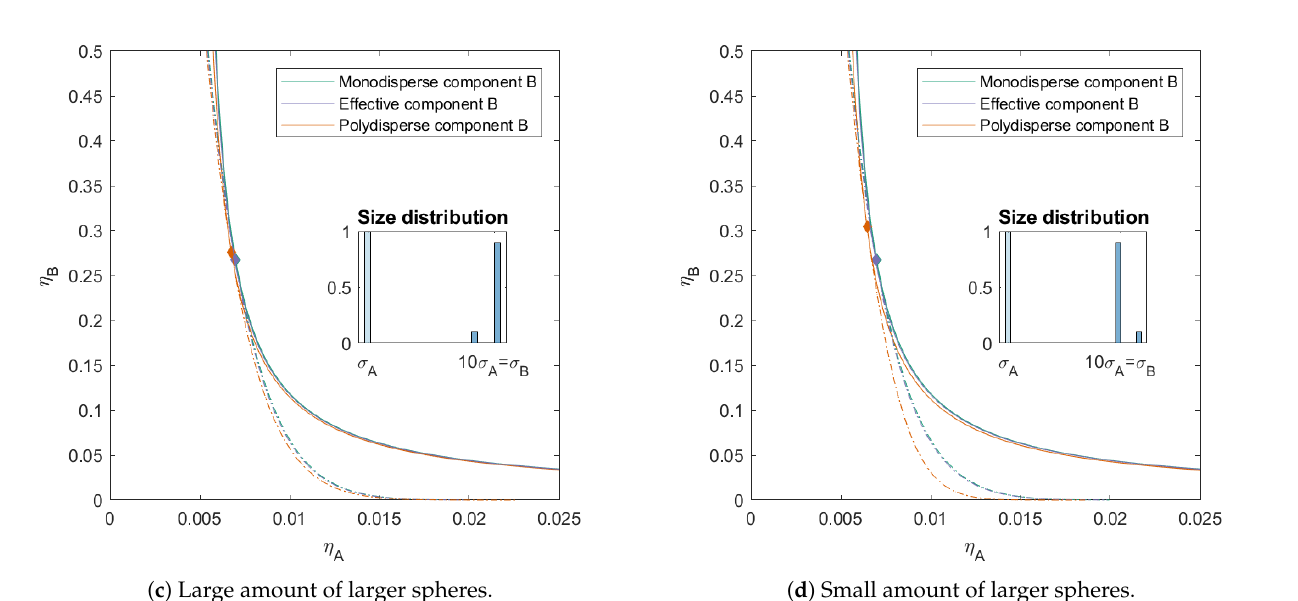
Figure 5. Phase diagram for binary (component A and B ) additive hard sphere mixture with size ratio q = σ A / σ B = 1/10, component A is monodisperse, component B is polydisperse (see size distribution), with a number average size 10 times the size of component A , plotted as a function of the partial packing fractions, η A and η B . The spinodal ( solid line ) and binodal ( dashed line ) meet each other at the critical point